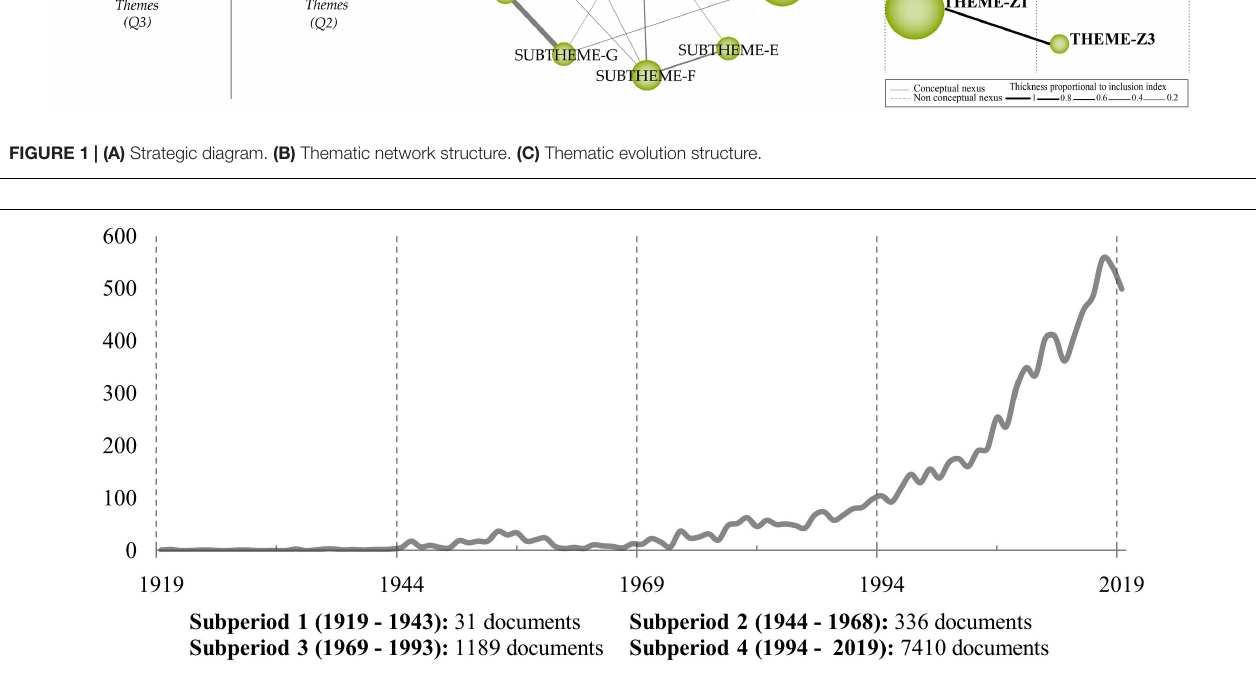
FIGURE 2 | Number of publications over time (1919–October 2019).